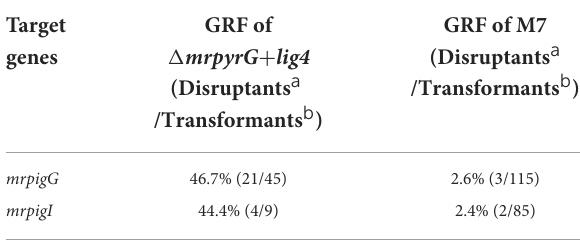
TABLE 3 GRF in the wild-type (M7) and 1 pyrG + lig4